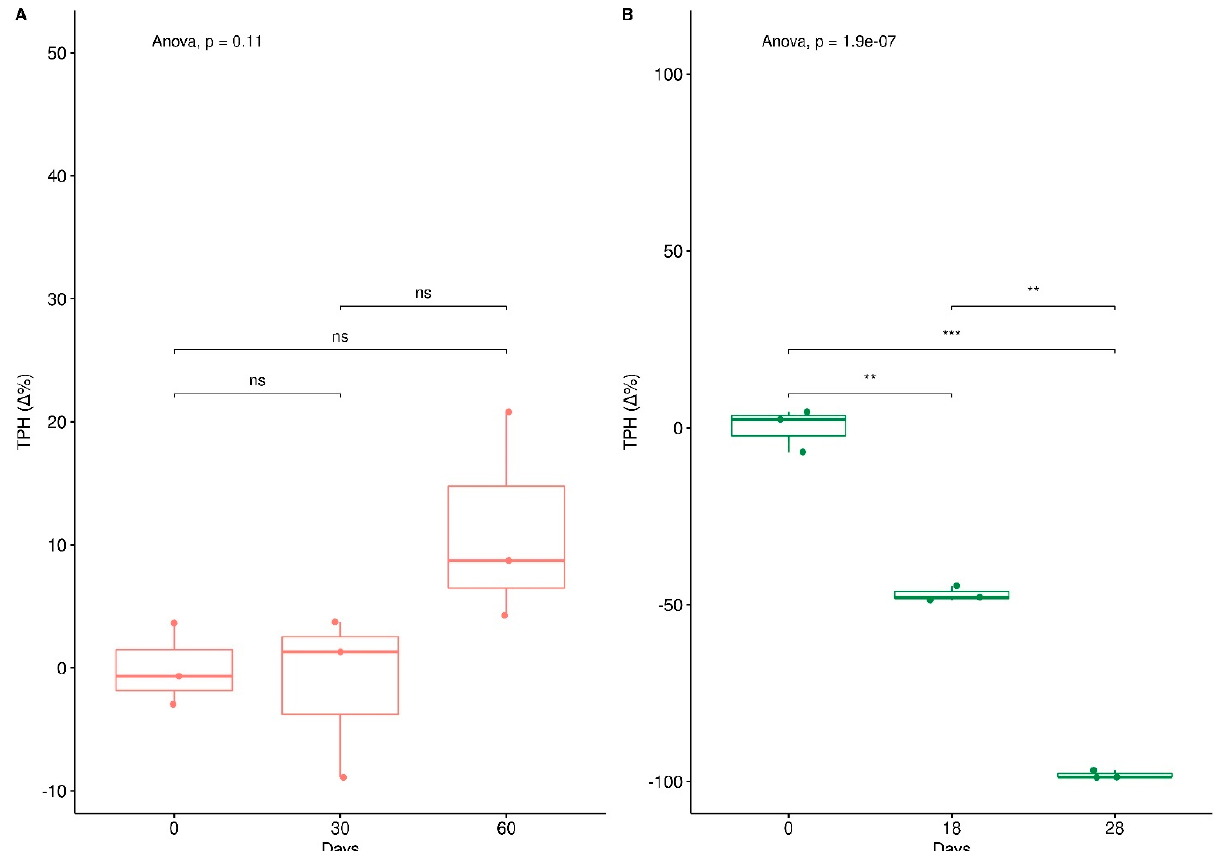
Figure 1. Percentage of variation in TPH content. Reported boxplots represent the mean variation of TPH concentration from the start of the bioaugmentation tests in presence of panel ( A ) Spent mushroom substrate (SMS), panel ( B ) Lambertella sp. MUT 5852, expressed as percentage. Three biological replicates per group are reported. Box and whiskers represent the minimum (Q 0 ), 1st quartile (Q 1 ), median (Q 2 ), 3rd quartile(Q 3 ), and maximum (Q 4 ) of each group. Global statistical significance was tested by one-way ANOVA. Horizontal bars indicate statistical significance of multiple comparisons, calculated by post hoc paired t -tests between group means. Notation for p -value: ns for p > 5 ×10 − 2 ; ** for p ≤ 1 × 10 − 2 ; *** for p ≤ 1 × 10 − 3 .